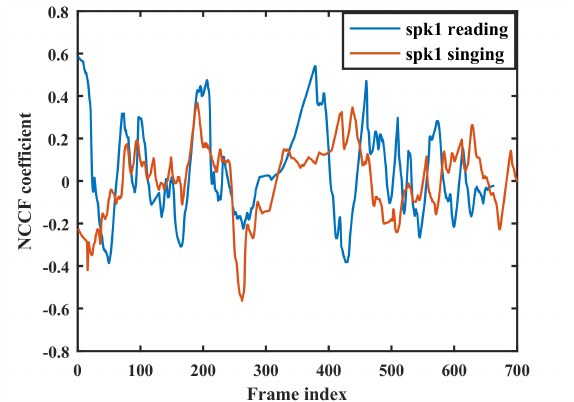
Figure 1. NCCF contour of the same speaker’s reading and singing speech with the same text.